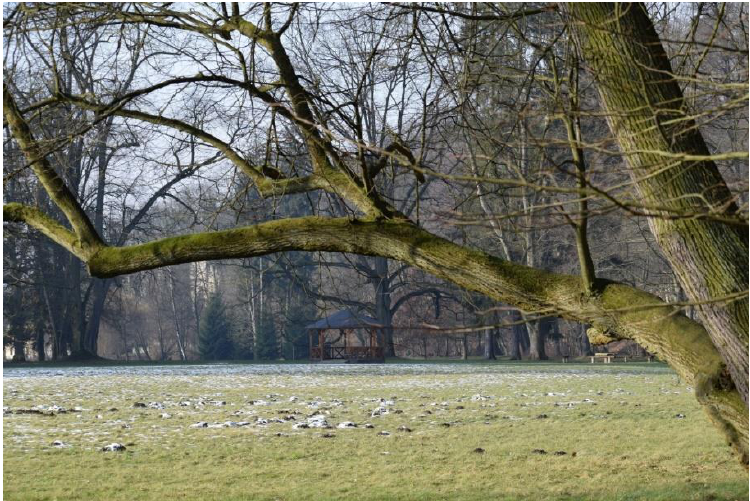
Figure 1. Peliny park. One of the areas for recreation and cultural events. Source: authors, 2021.